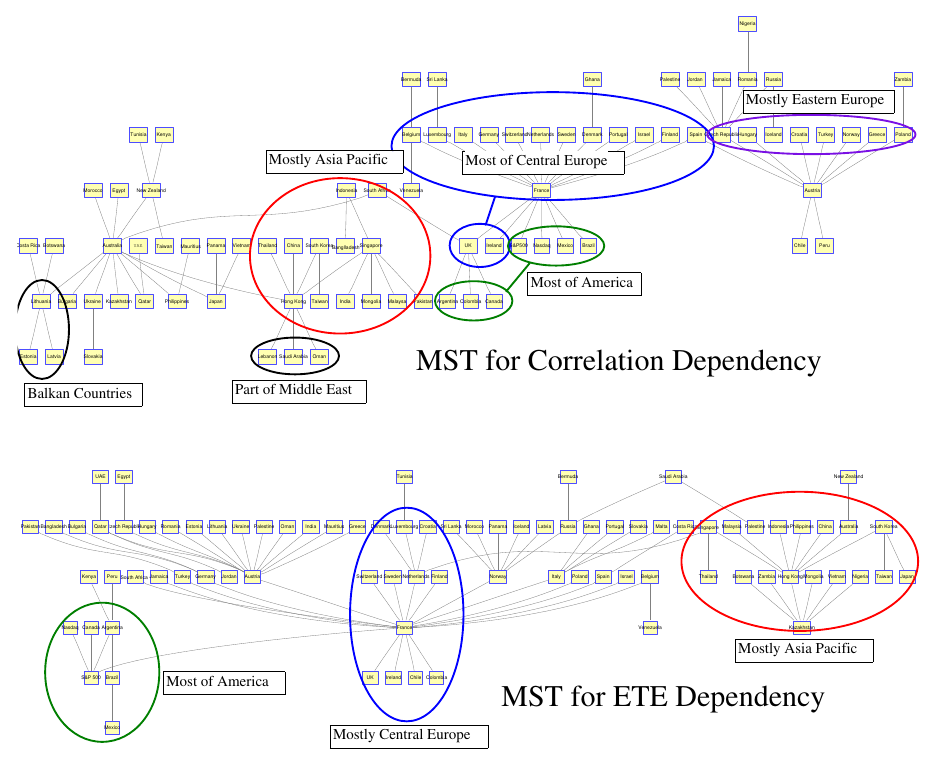
Figure 14. Minimum Spanning Trees (MSTs) of the correlation and ETE dependency